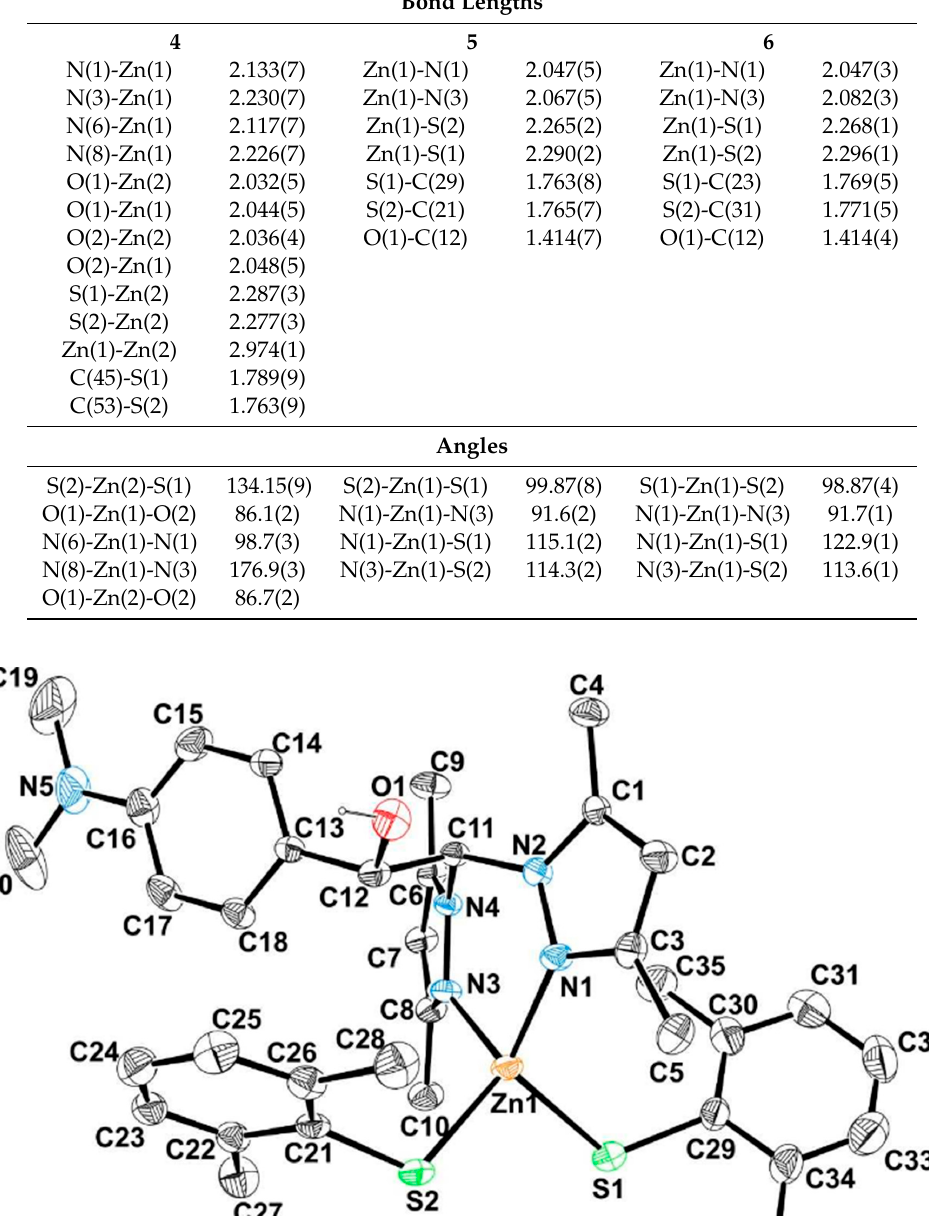
Table 1. Selected bond lengths (Å) and angles ( ◦ ) for 4 , 5 and 6 .